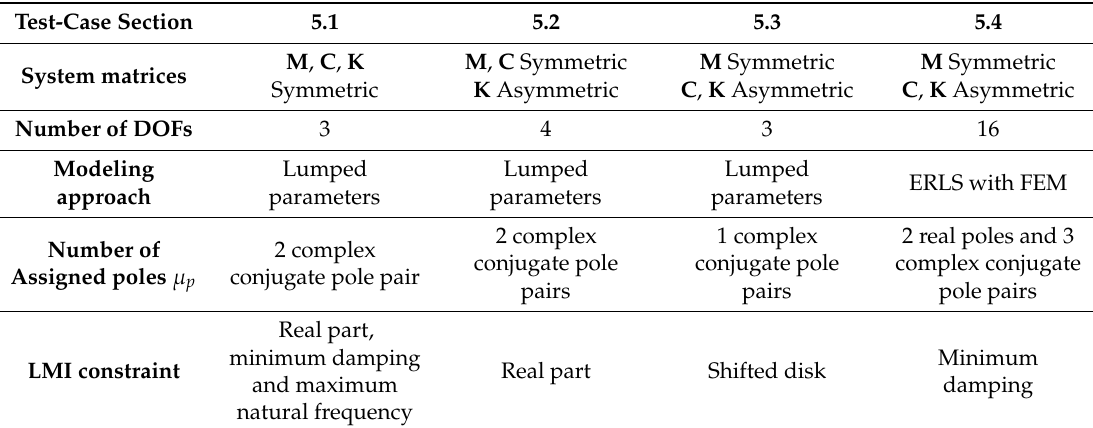
Table 1. Summary of the four test-cases.